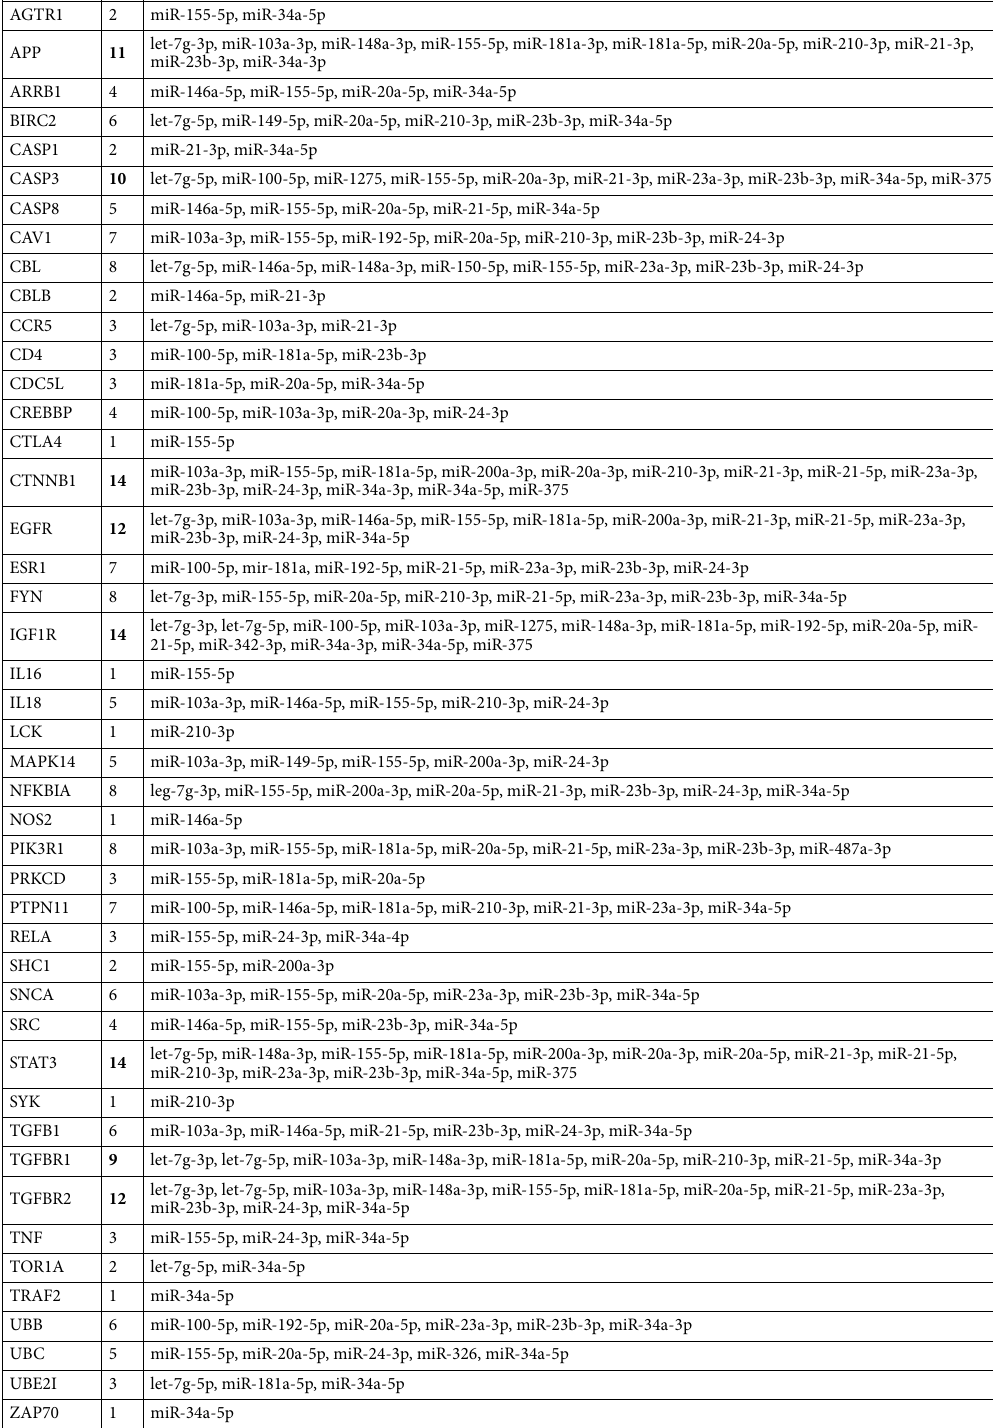
Table 4. The T1D-related miRNAs targeting backbone